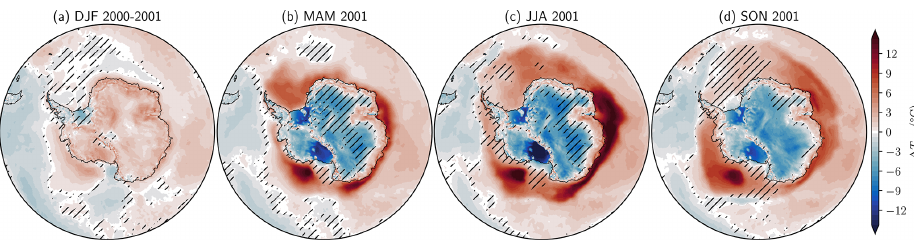
Figure A3. (PARASO–JRA-55) (Kobayashi et al., 2015) differences in seasonally averaged 2m air temperature for the second simulated year. The used color bar is the same as that in Fig. 11. Hatching denotes areas where the PARASO–JRA-55 and PARASO–ERA5 (see Fig. 11) differences are of contrary signs.